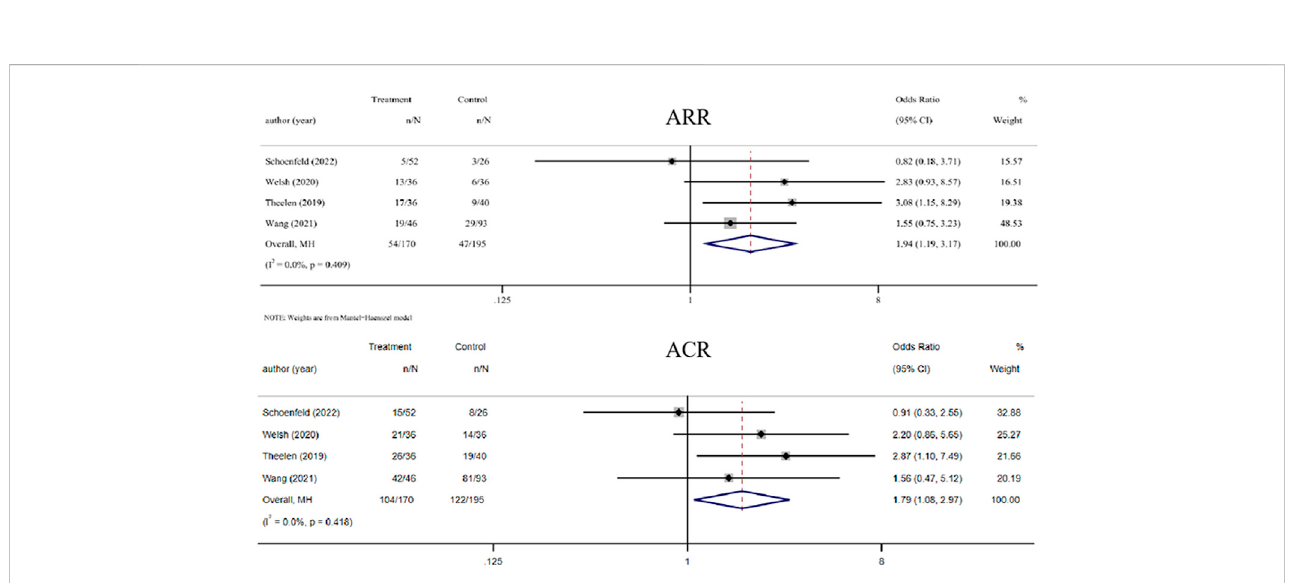
FIGURE 3 Forest plot of abscopal local control beyond the irradiation fi eld associated with radiotherapy combined with ICIs versus ICIs alone. In terms of ARR and ACR, the ORs of RT combined with ICIs treatment were 1.94 (1.19, 3.17) and 1.79 (1.08, 2.97), respectively. Abbreviations: RT, radiotherapy; ICIs, immune checkpoint inhibitors; OR, odds ratio, ARR, abscopal response rate; ACR, abscopal control